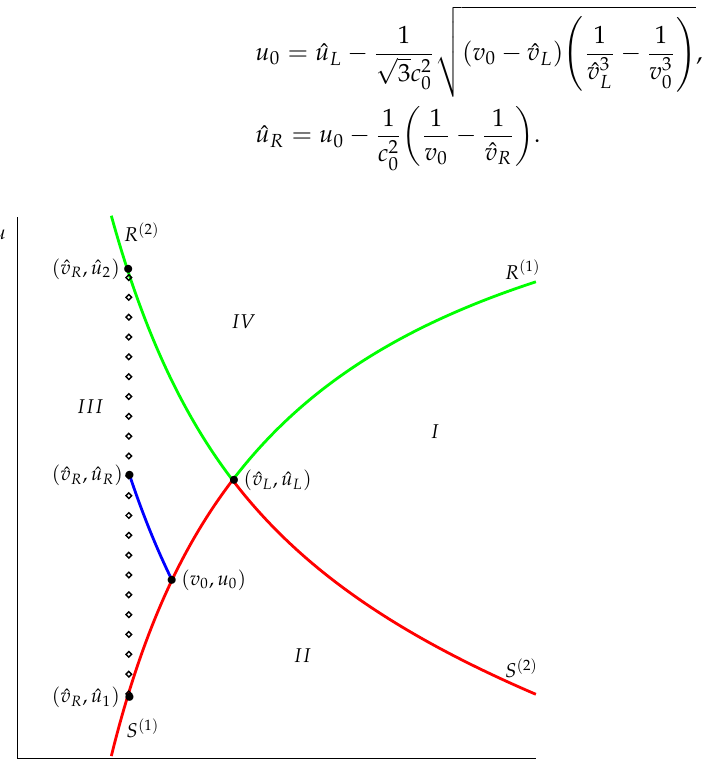
Figure 2. Generalised rarefaction curves and shock curves passing through ( ˆ v L , ˆ u L ) in the ( v , u ) plane. In red, the shock curves S ( 1,2 ) , and in green, the generalised rarefaction curves R ( 1,2 ) . The point ( v 0 , u 0 ) ∈ S ( 1 ) ( v , ˆ v L , ˆ u L ) characterizes the central state